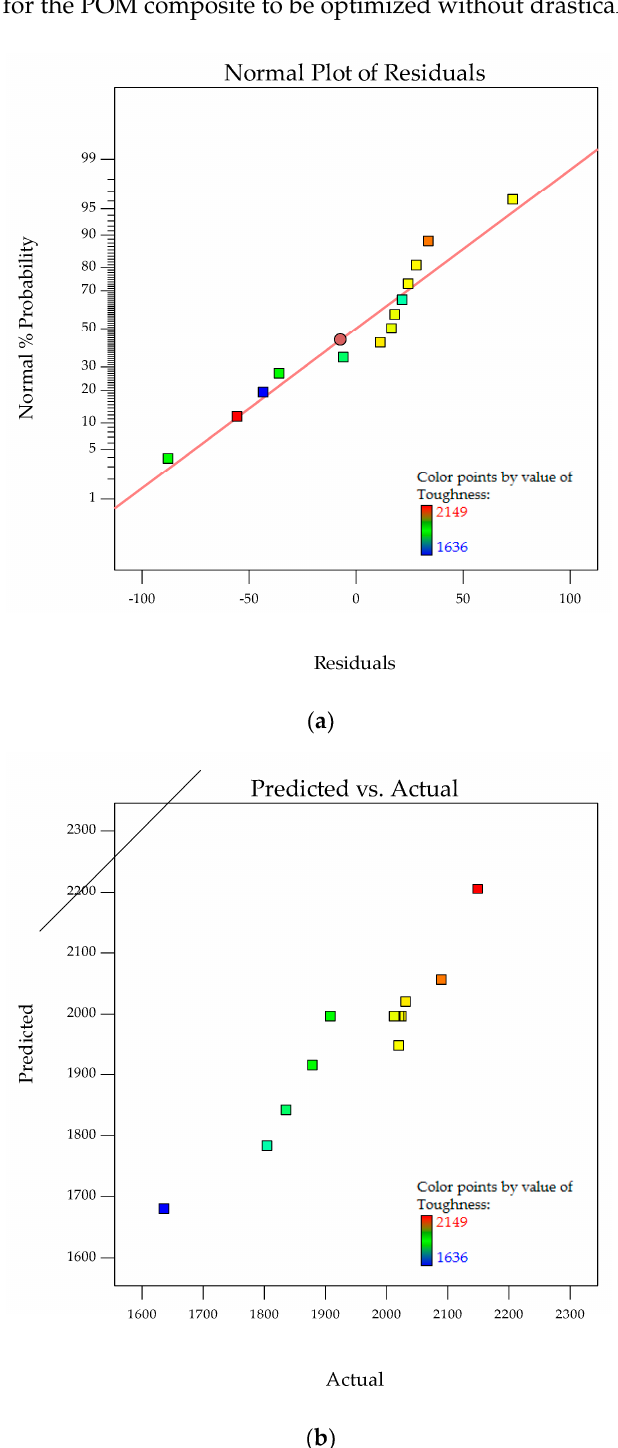
Figure 8. Stochastic error and deterministic portion for toughness of POM composites as ( a ) normal probability plot for residuals; ( b ) predicted versus actual values.